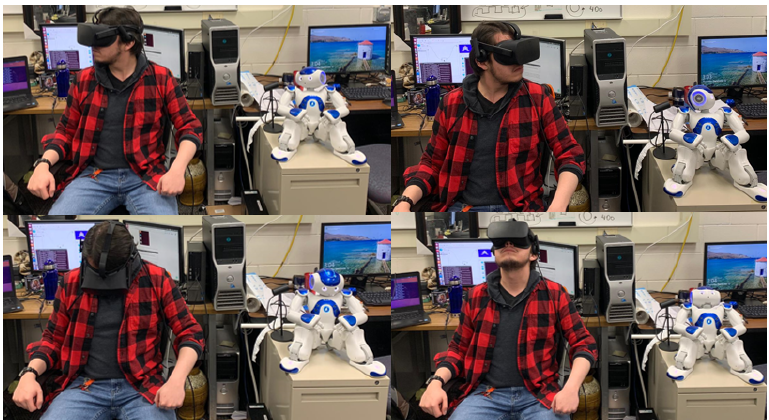
Figure 20. Process of imitation for NAO robot head